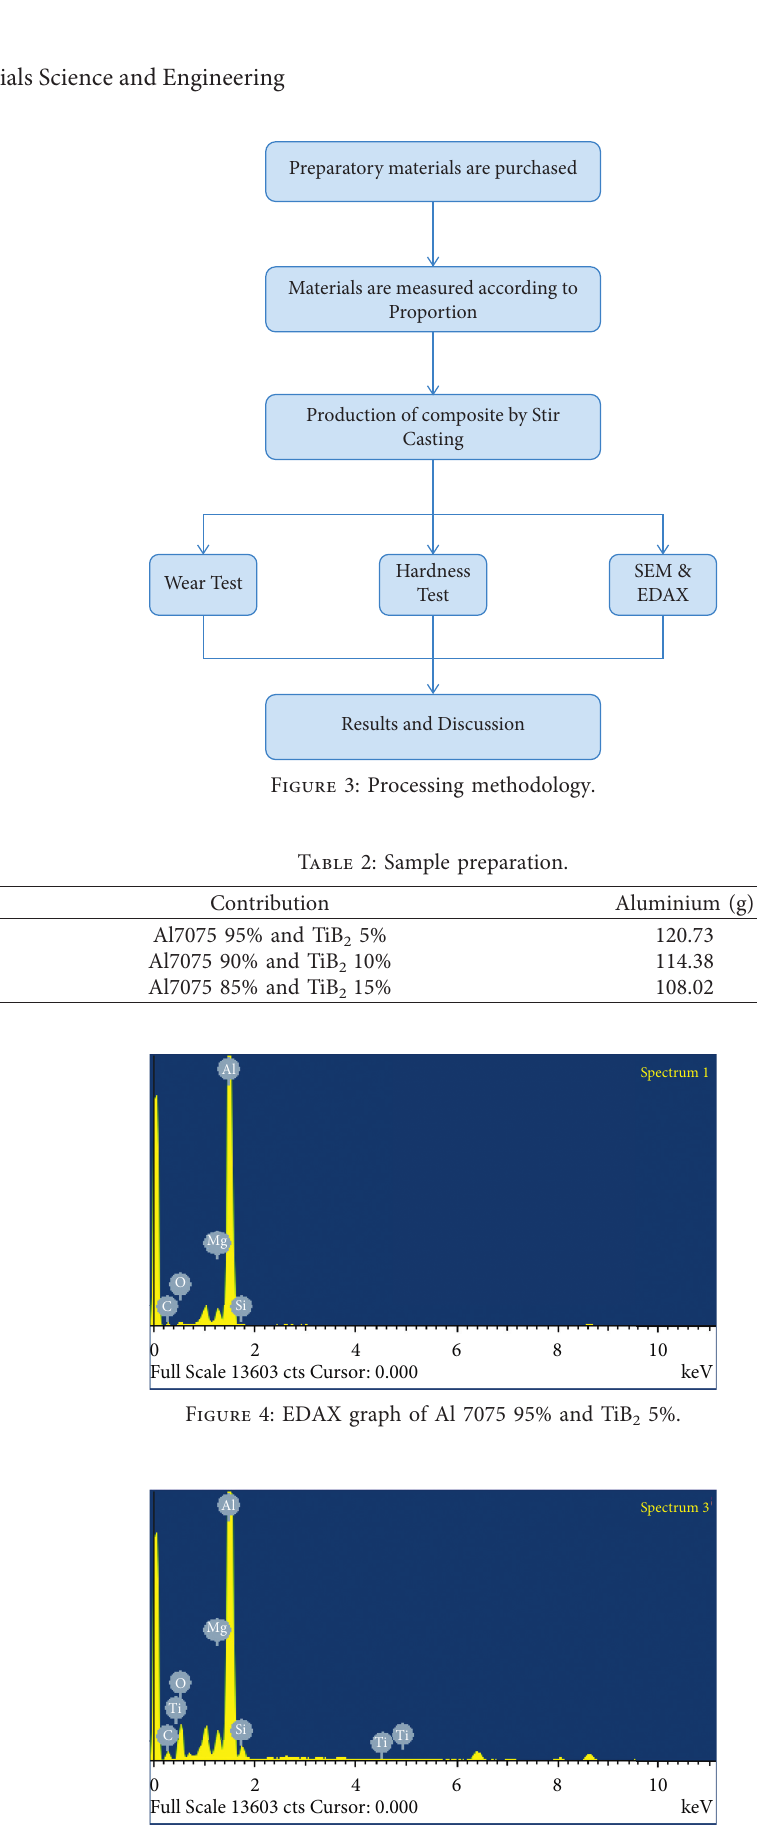
Figure 5: EDAX graph of Al7075 90% and TiB